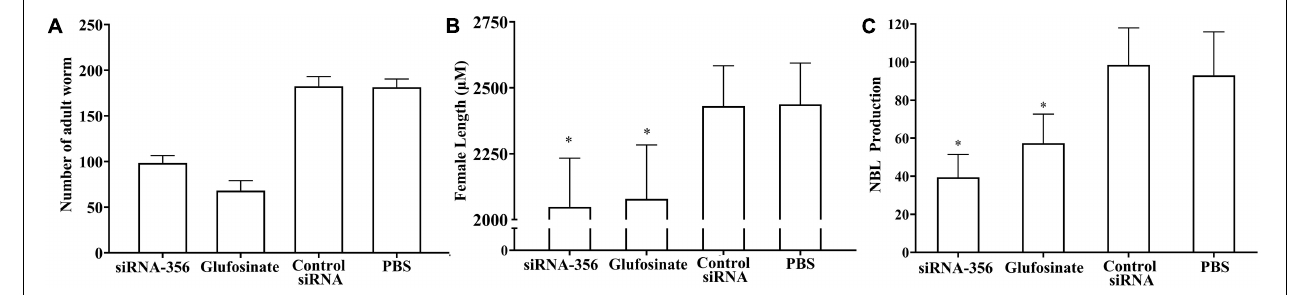
FIGURE 13 | Intestinal adult burden, female length, and fecundity of mice infected with muscle larvae transfected with siRNA-356. (A) Intestinal adult burdens ( n = 10). (B) Female adult length ( n = 30). (C) Female fecundity ( n = 10). ∗ P < 0.0001 compared with the control siRNA and phosphate-buffered saline group.